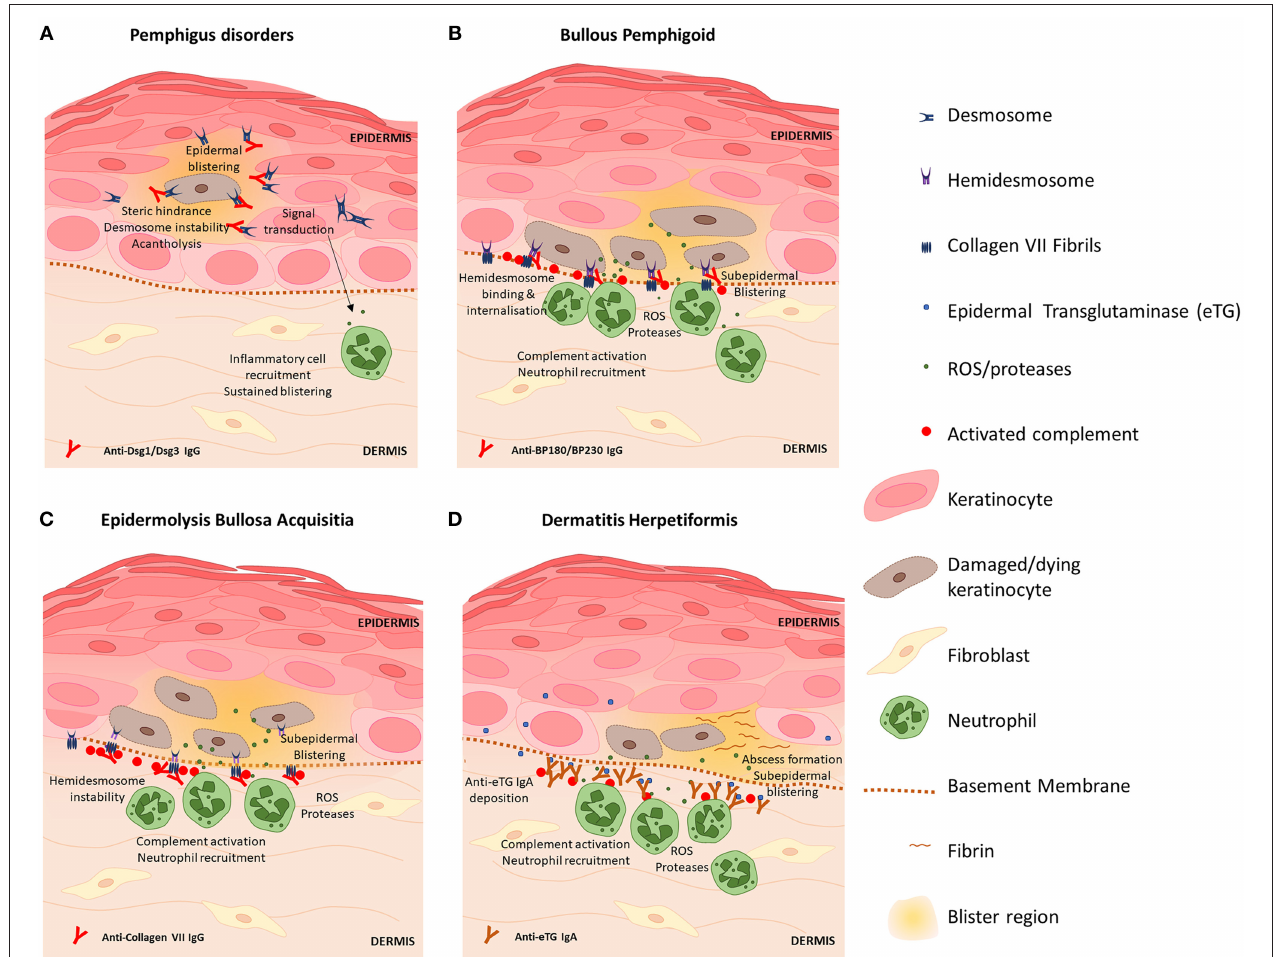
FIGURE 1 | Blistering mechanisms of prototypic autoimmune skin blistering disorders result in skin barrier disruption. (A) Pemphigus disorders are caused by autoantibodies against desmoglein (Dsg) proteins Dsg1 and Dsg3. Binding of anti-Dsg destabilizes desmosomes to cause acantholysis of keratinocytes within the epidermis and triggers keratinocyte signal transduction events which promote inflammation, skin barrier disruption and further skin blistering. (B) Blisters in bullous pemphigoid are caused by anti-BP180 antibodies which bind hemidesmosomes on basal keratinocytes and trigger complement activation and inflammatory responses including ROS and protease release by neutrophils which directly kill keratinocytes. Skin barrier disruption and skin blistering is caused by keratinocyte death and sustained localized inflammation. (C) Epidermolysis bullosa acquisita is caused by anti-Collagen VII antibodies which bind fibrils that anchor hemidesmosomes to the basement membrane. Deposition of IgG induces complement activation via the classical pathway and activation of neutrophils. Basal keratinocytes sustain damage via action of neutrophil-derived ROS and proteases resulting in splitting at the dermal-epidermal junction and skin barrier disruption. (D) Dermatitis hepetiformis (DH) is caused by cross-reactive antibodies that bind epidermal transglutaminase (eTG). eTG is produced by keratinocytes and accumulates in the papillary dermis where it forms immunogenic immune complexes with anti-eTG IgA that trigger complement activation. Fibrin deposition and influx of